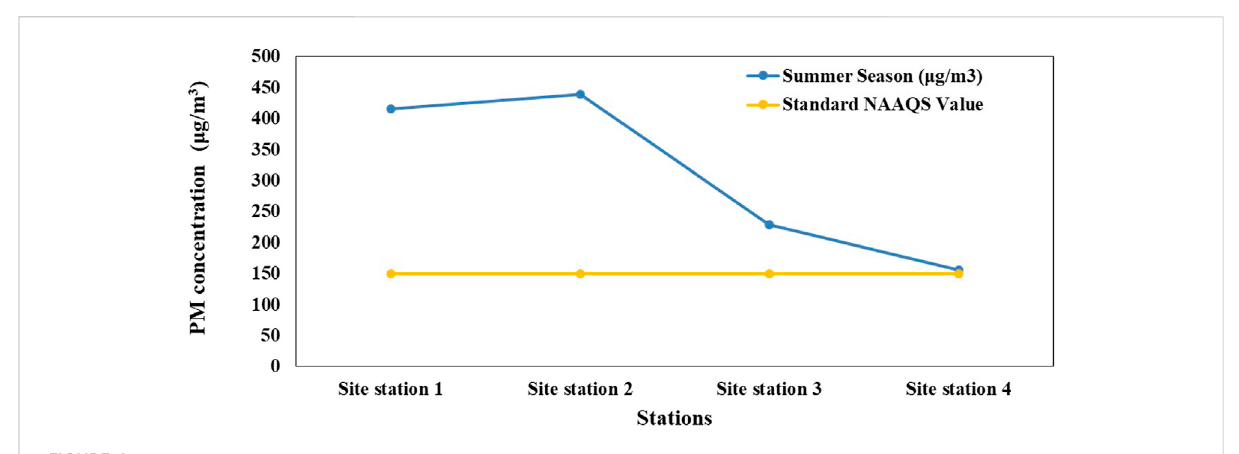
FIGURE 4 PM concentration in the summer